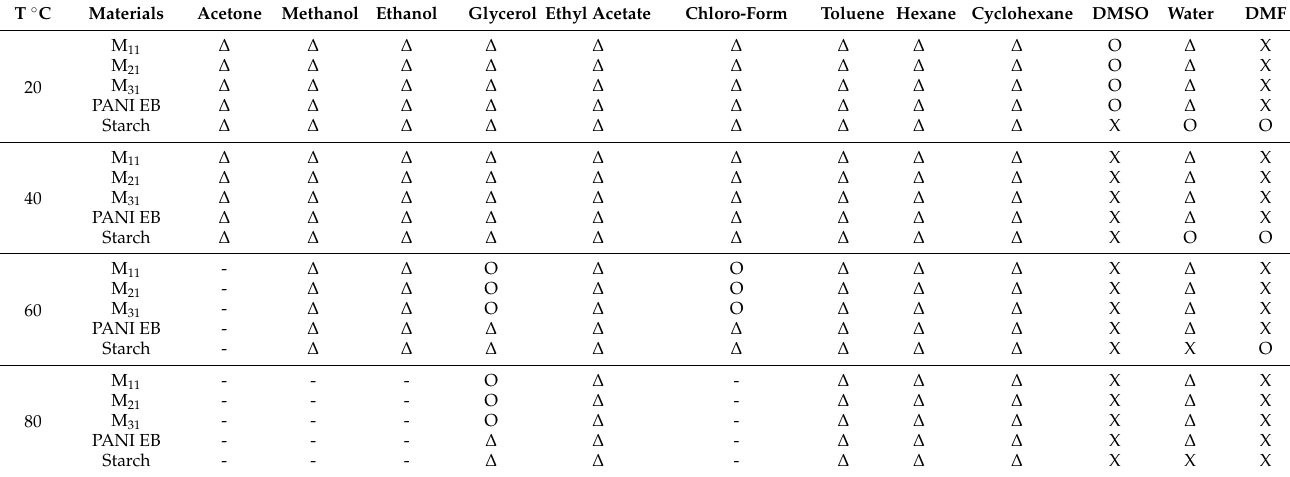
Table 3. Solubility test of PANI, STARCH, and PANI/starch